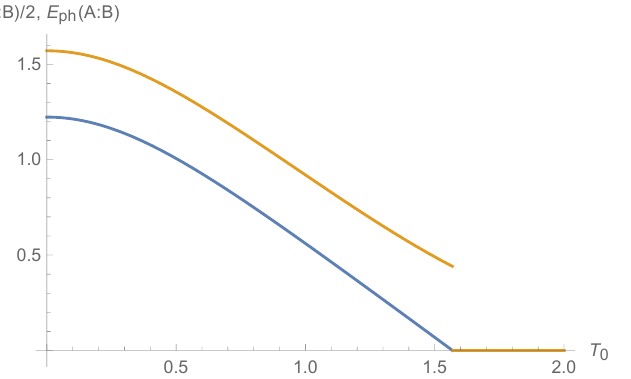
Figure 12. We plot the E ph (in orange) and half the mutual information (in blue) as a function of T 0 , with z H = 1 = 2, G N = 1 and L AdS = 1. The mutual information becomes zero at around T 0 = 1 :